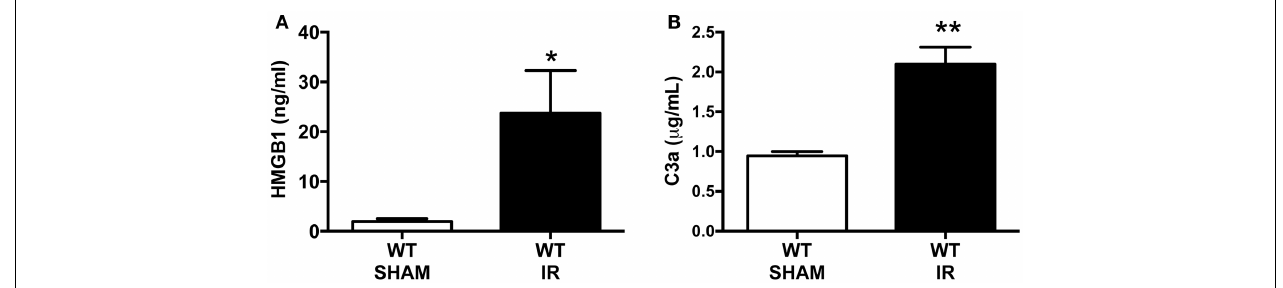
FIGURE 1 | Intestinal ischemia reperfusion (IR) injury induces systemic blood elevation of RAGE ligands . Wild-type (WT) mice were subjected to 30min mesenteric artery occlusion, followed by 150min of reperfusion to induce intestinal IR injury. Alternatively, sham-operated mice underwent the same procedure, except the mesenteric artery was not occluded (SHAM). The plasma levels of (A) HMGB1 and (B) C3a were measured using standard ELISA kits at the end of the reperfusion period. Data are presented as mean (cid:6) SEM, n = 4 (WT-SHAM) n = 8 (WT-IR) where * p < 0.05, ** p < 0.01 compared with WT-SHAM.